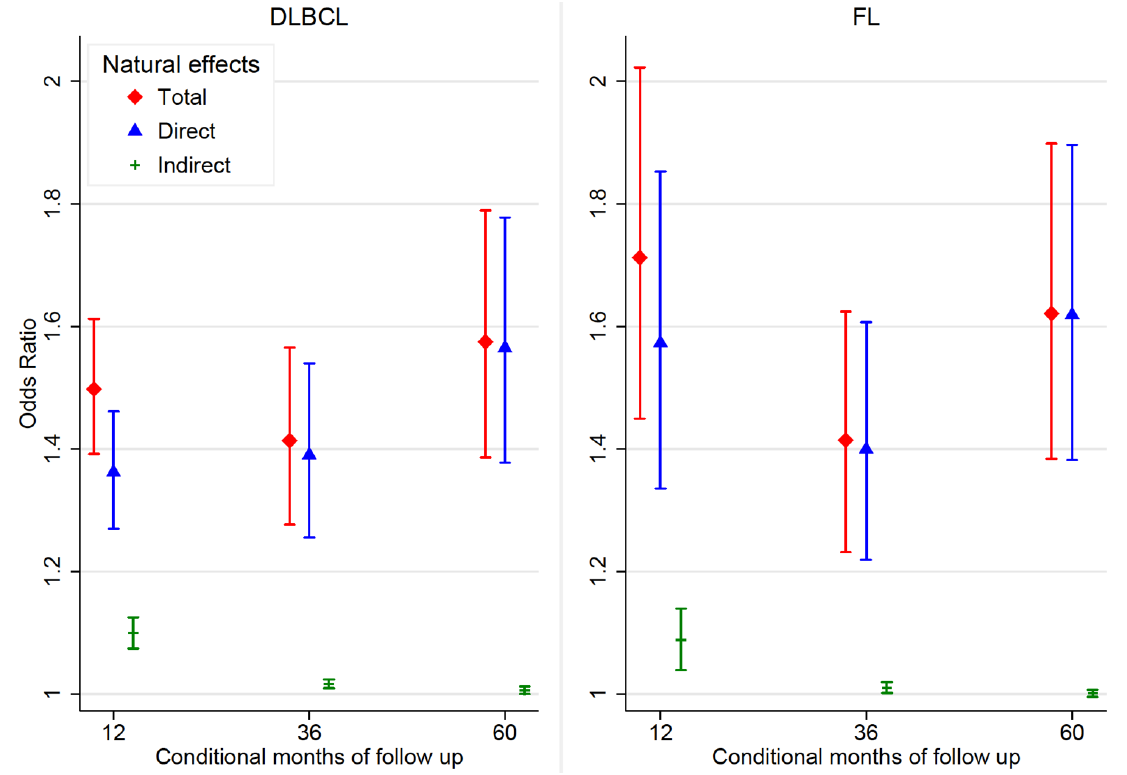
Figure 4. Effect of comorbidity status on odds of death at different conditional months of follow up since diagnosis amongst DLBCL ( n = 27,379) or FL ( n = 14,043) patients in England between 2005 and 2013.